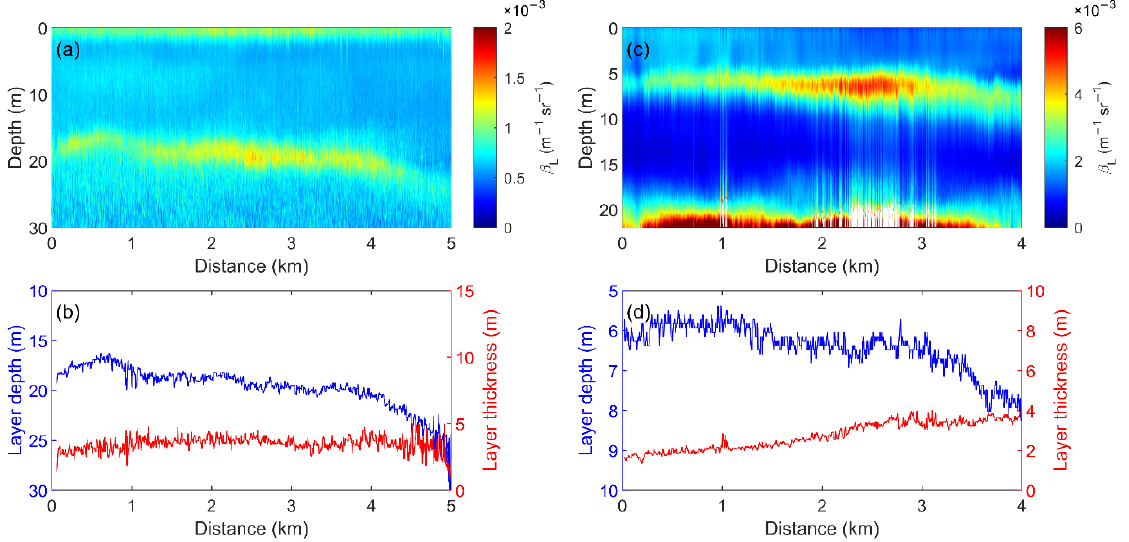
Figure 4. Vertical slices of volume backscattering coefficient and the corresponding thin layer depth and thickness expressed as the blue and red lines, respectively. ( a ) Vertical slice of β L on 24 September; ( b ) Corresponding layer depth and thickness on 24 September; ( c ) Vertical slice of β L on 4 October; ( d ) Corresponding layer depth and thickness on 4 October.